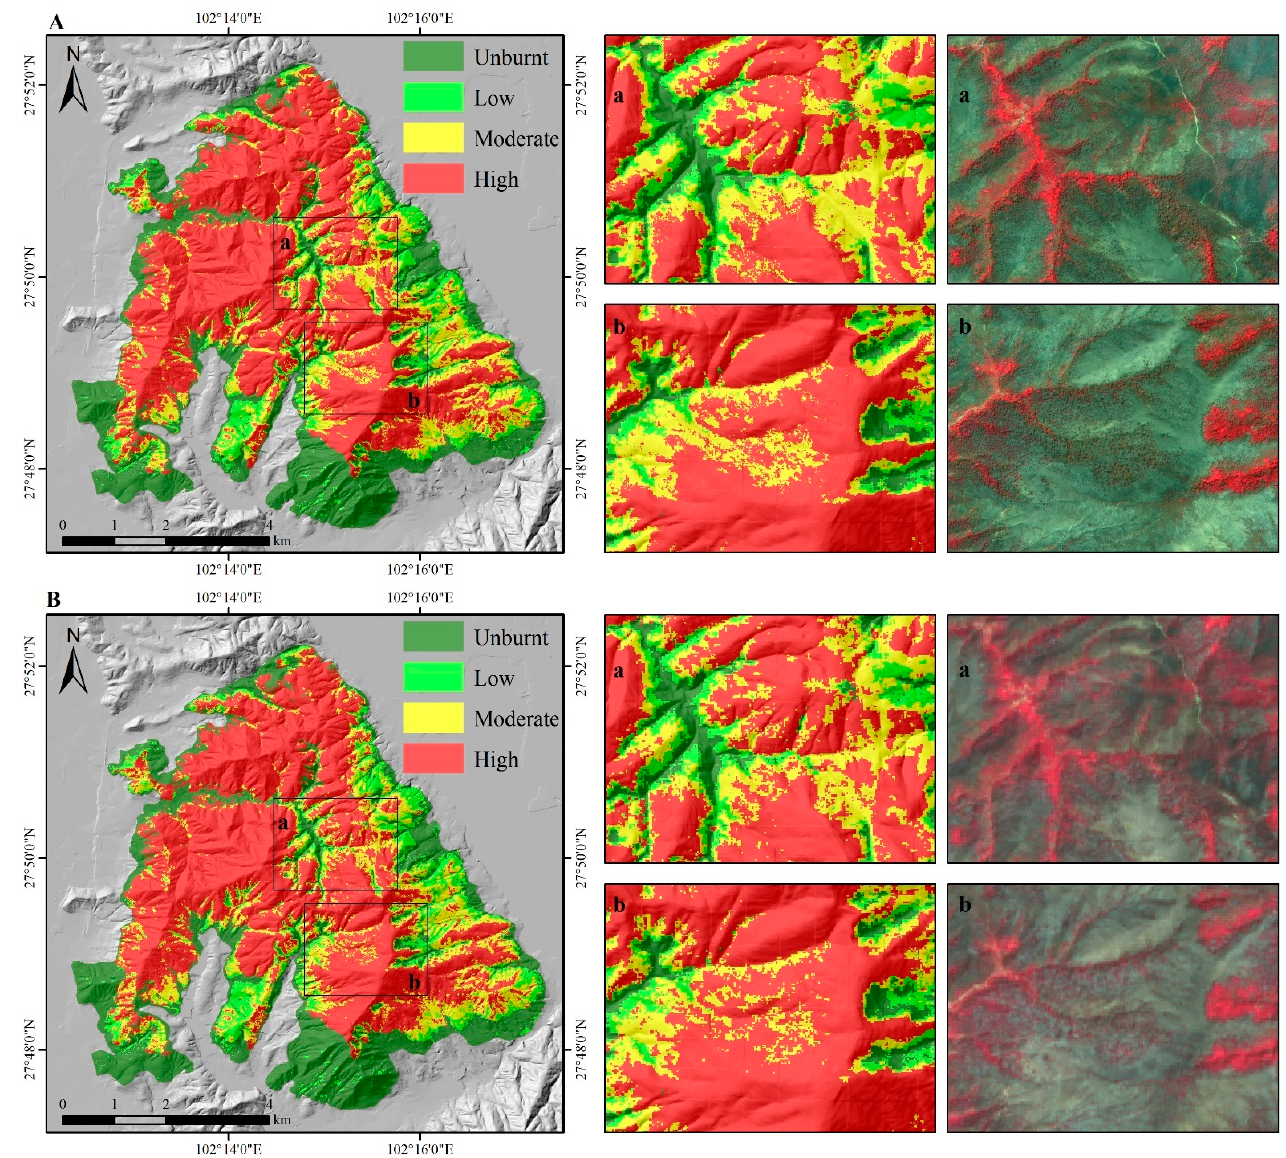
Figure 3. Fire severity maps. ( A ) Result of the S2-GF model and the GF-1 image on 18 April 2020; ( B ) result of the S2 model trained without GF data and the Sentinel 2 image on 4 April 2020. There were no significant differences in the spatial pattern of fire severity between the results of the two models. However, the S2-GF model trained with the combination of the Sentinel 2 data and GF data predicted more accurately, especially in the transitional areas where the fire severity changes from low to high (region a and region b in the figure).